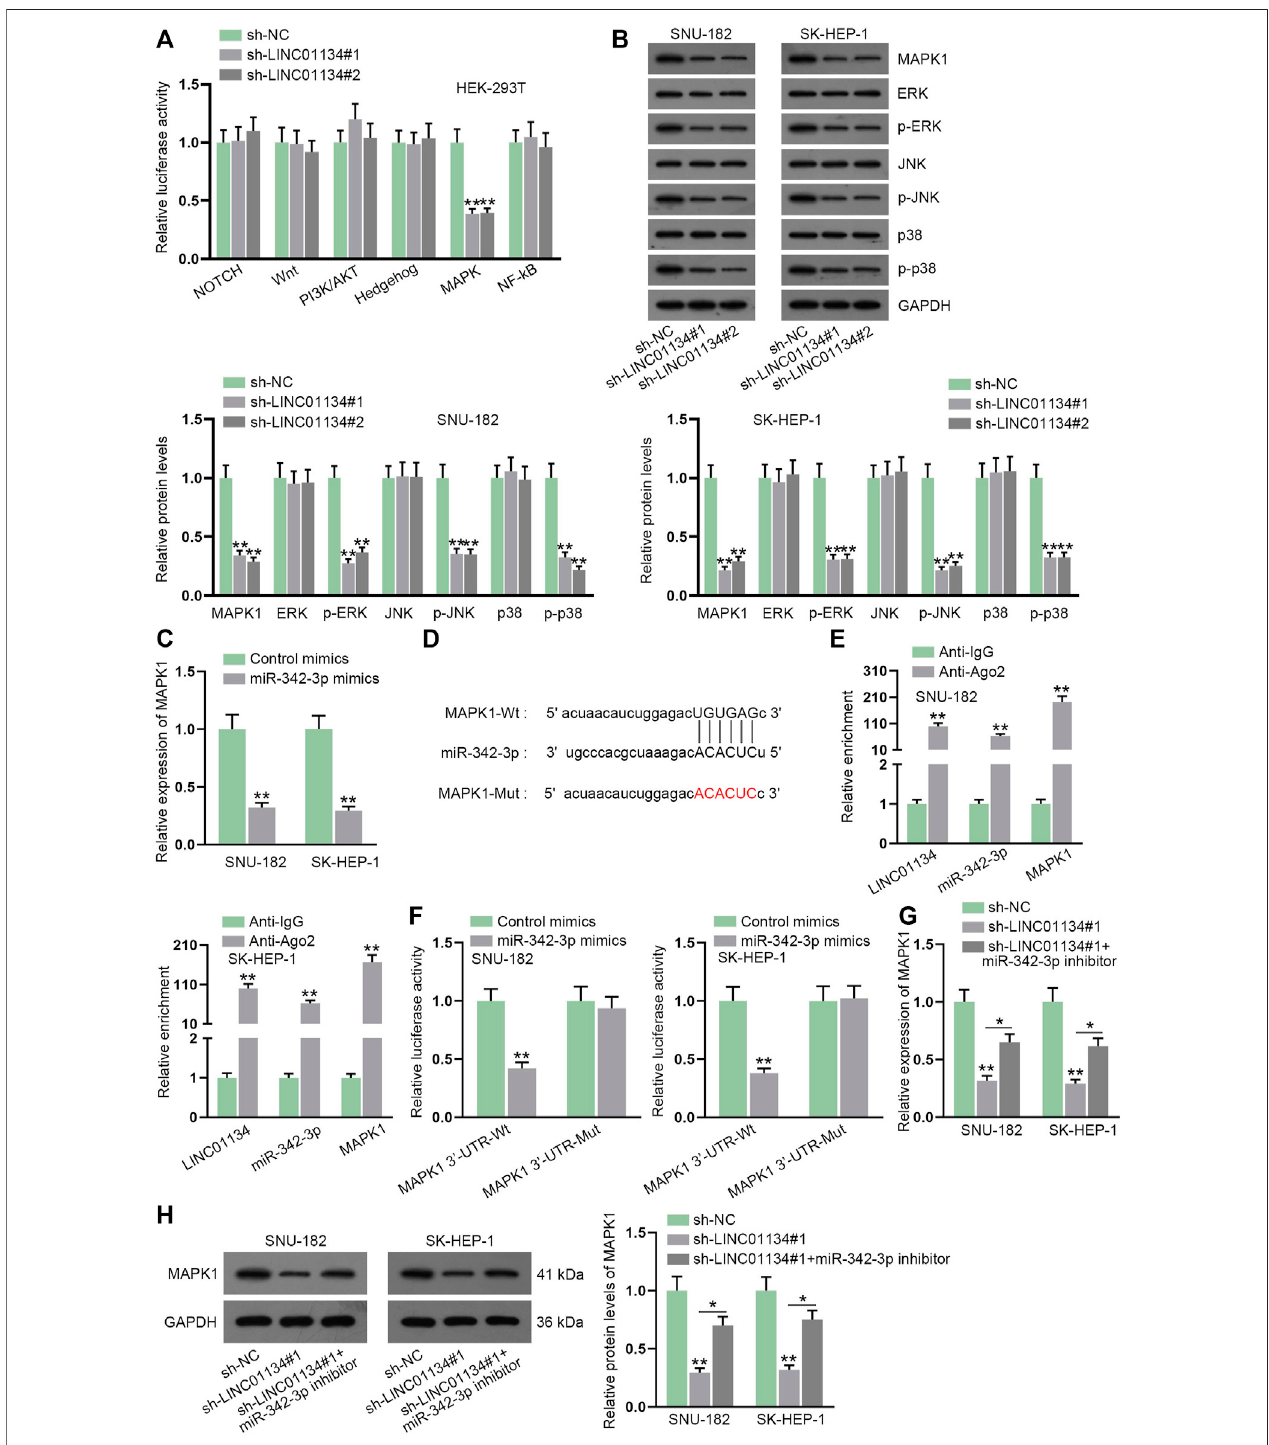
FIGURE 5 | LINC01134 sponges miR-342-3p and modulates MAPK1 expression to activate MAPK signaling pathway. (A) Luciferase reporter assay was done to analyze the luciferase activity of six common signaling pathways when LINC01134 was downregulated. (B) Western blot was conducted to analyze the protein levels of MAPK1anddownstreamfactors oftheMAPKsignalingpathway. (C) RT-qPCRwasexecuted todetectMAPK1expression aftermiR-342-3pwasupregulated. (D) The wild-typeandmutatedbindingregionsbetweenmiR-342-3pandMAPK1weredisplayed. (E) RIPassaywasperformedtoevaluatetheenrichmentofLINC01134, miR-342-3p, and MAPK1 in Anti-Ago2. (F) Luciferase reporter assay was employed to test the binding of miR-342-3p and MAPK1. (G,H) MAPK1 expression was examinedinthesh-NC group,sh-LINC01134#1group,andsh-LINC01134#1+miR-342-3pinhibitor groupbyRT-qPCRandwesternblotassays.* p < 0.05,** p < 0.01.